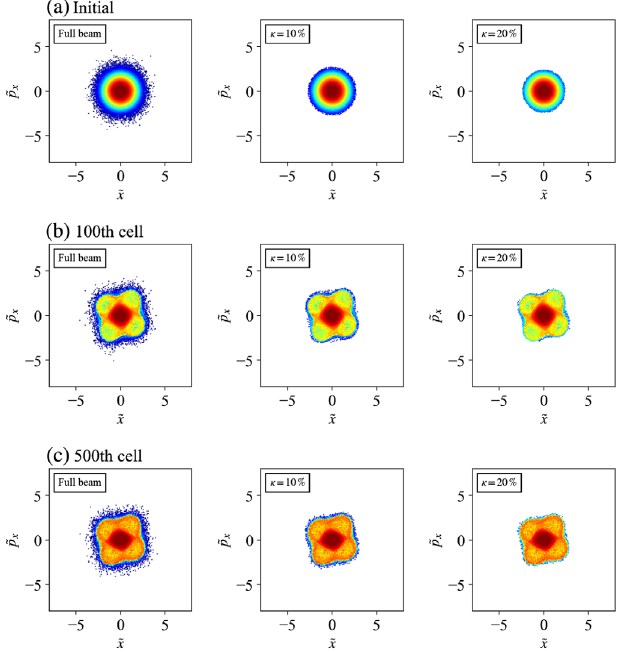
FIG. 5. Phase-space configurations at ν 0 ¼ 0 . 263 with three different tail-truncation factors ( κ ¼ 0 , 10, 20), observed at (a) the transport entrance, (b) 100th FD cell, and (c) 500th FD cell.